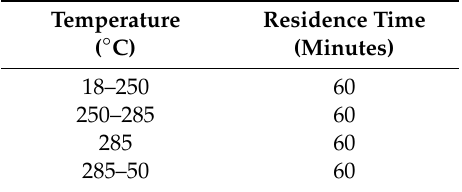
Table 5. Stages used in the test T4 from Series